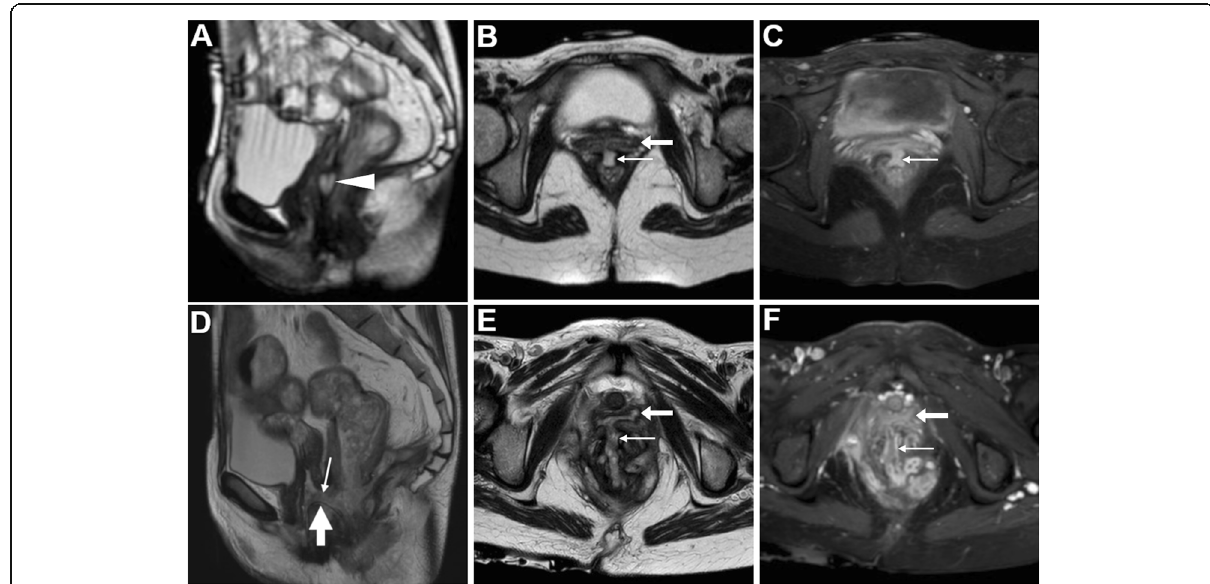
Fig. 11 MRI follow-up of worsening perianal inflammatory disease in a 40-year-old with severe, refractory CD. Initial MRI ( a - c ) shows a small-sized abscess of the anovaginal septum (arrowhead in a ) originating from a midline recto-VF (thin arrows) with strong enhancement on FS T1- weighted image after gadolinium CM ( c ). Two years later, despite positioning of a seton (thick arrow in d ), repeated MRI ( d - f ) shows development of complex perianal disease including widened recto-VF (thin arrows) and formation of abscesses in both levator ani muscles. Note vagina (arrows)